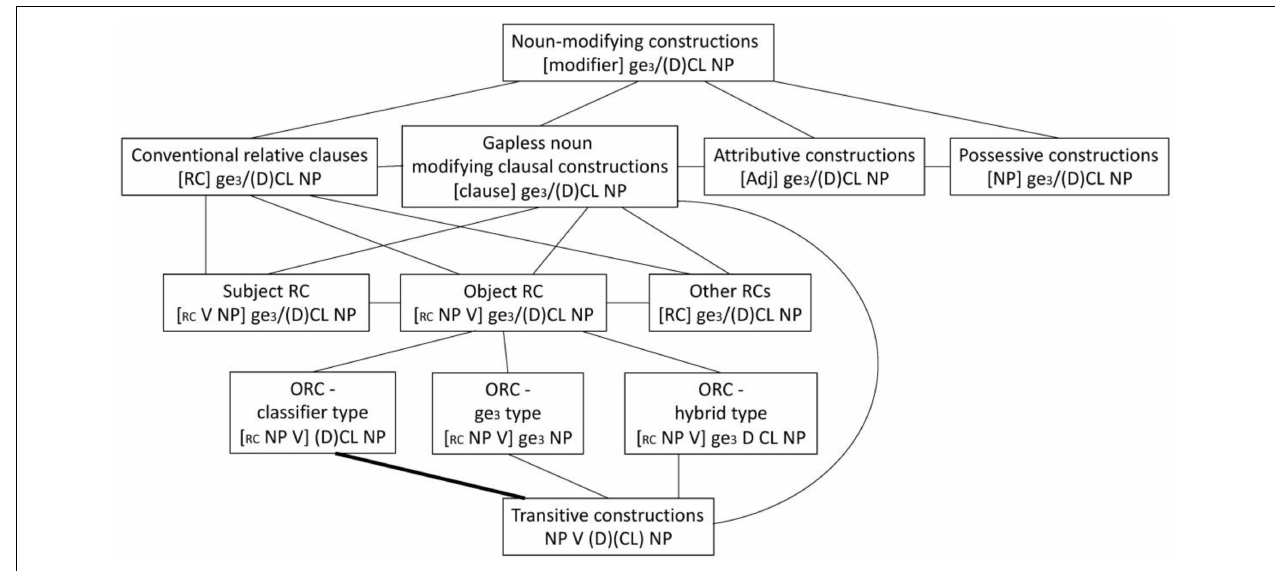
FIGURE 5 | Relative clauses in a network of related constructions in